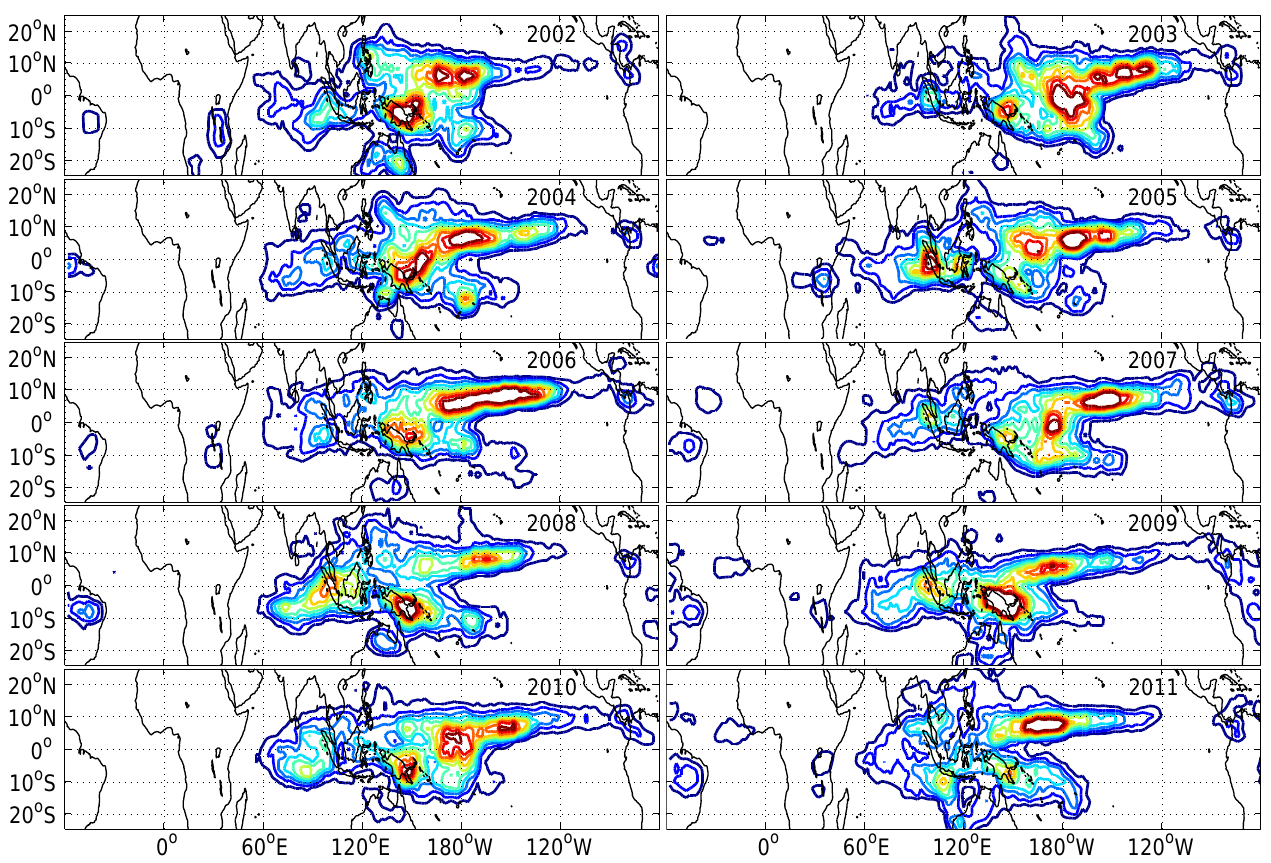
Fig. 8. Density distribution function of the horizontal positions of the last contact with the boundary layer for all years from 2002–2011. The values are normalized such that a horizontally uniform distribution corresponds to a value of 1 at every grid point. Contours as in Fig.